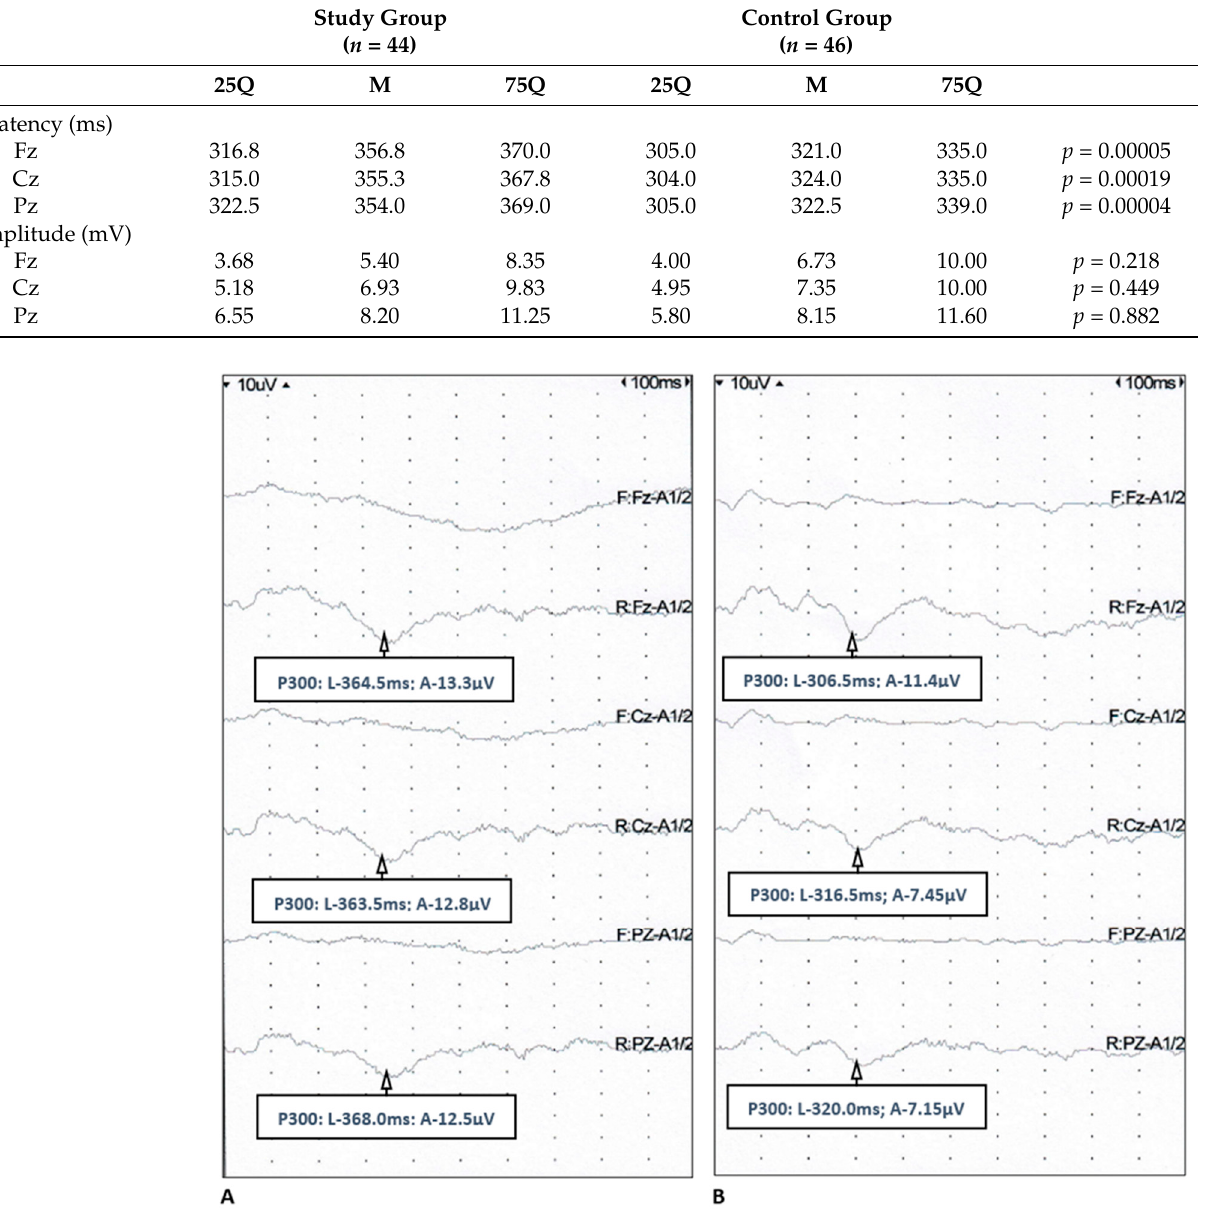
Figure 1. P300 event-related potential: in a 28-year-old woman with epilepsy ( A ) and a 30-year-old woman from the control group ( B ) (L—latency, A—amplitude).